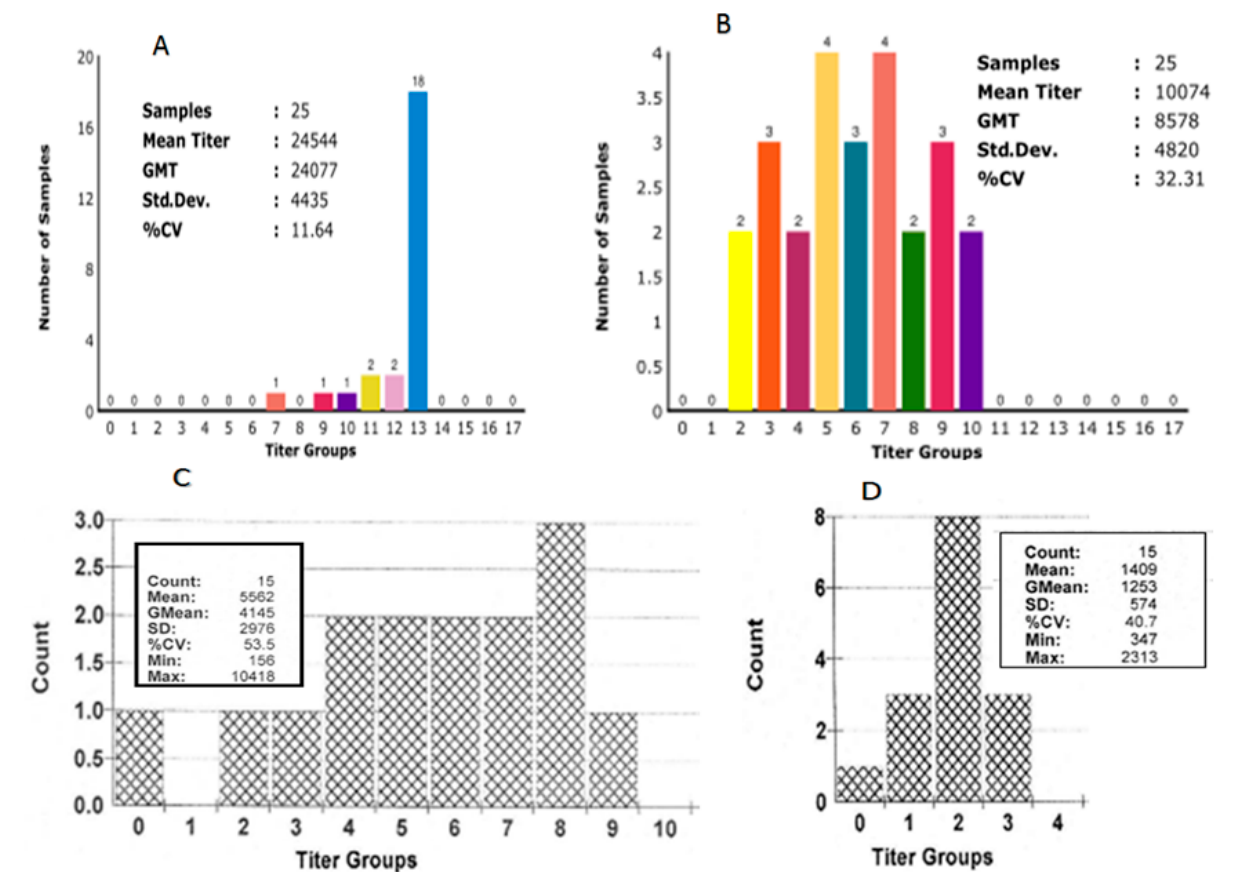
Figure 2. Compared serology analysis of IBV in two broiler breeder houses at 26 weeks of ( A ) challenged and ( B ) normal flock. Probable calculation of mean titer of challenged flock was three times more than that of the normal flock, and coefficient of variation (CV%) was too low compared with previous serology using Symbiotic test kit, USA. High-challenge titer after IBV infection in peak laying located almost in a single bar. In broilers, ( C ) high-challenge titer after IBV infection observed at the age of 35 days over 3–4 K titer calculated as post-IBV infection compared with ( D ) normal serology based on standard of Idexx ELISA test kit, USA. (Source: Personal communication; collected from Tuaran Broiler Farm, Sabah, Malaysia).